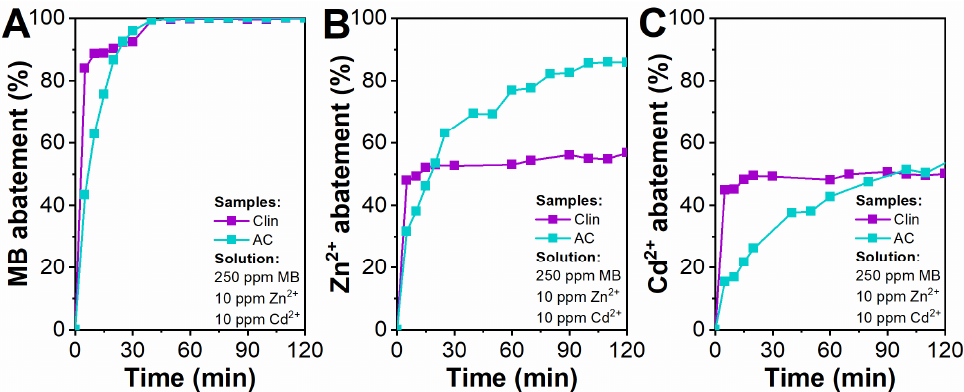
Figure 6. Clin and AC abatement tests (10 g L − 1 ) with 250 ppm MB, 10 ppm Zn 2+ , and 10 ppm Cd 2+ . Abatement of MB ( A ), Zn 2+ ( B ), and Cd 2+ ( C ) as a function of time.